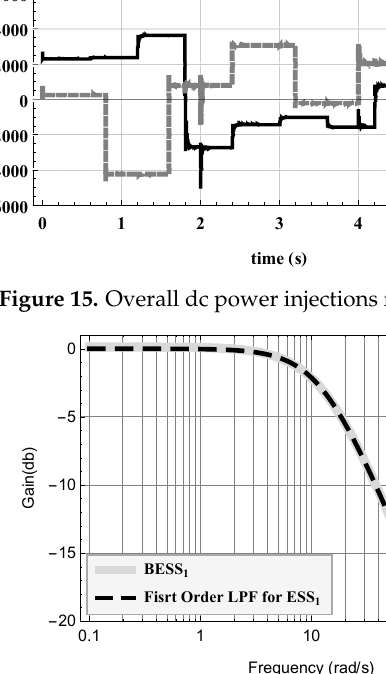
Figure 16. DGU 1 filter system response